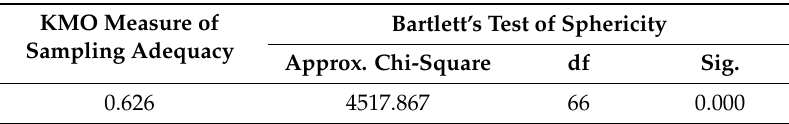
Table 3. KMO and Bartlett’s test.